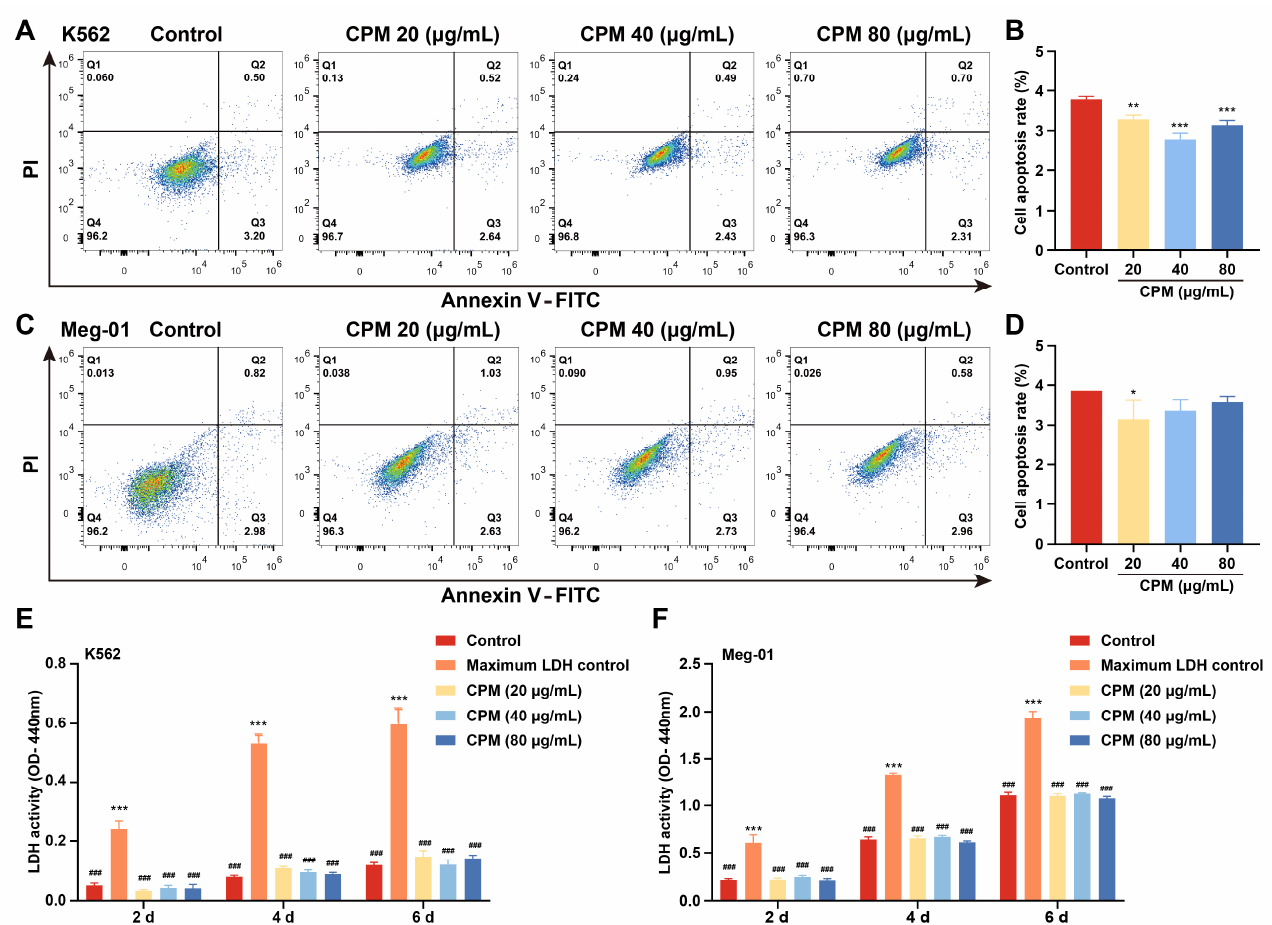
Figure 2. Cytotoxicity of CPM. ( A , C ) Apoptosis analysis in K562 and Meg-01 cells after treatment with or without CPM (20, 40 and 80 µg/mL) for 5 days. Q2 (Annexin + PI + ) denotes late apoptotic. Q3 (Annexin + PI − ) denotes early apoptotic cells. ( B , D ) Q2 + Q3 represents total apoptotic cells. Statistical analysis of apoptotic cells (Q2 + Q3) of K562 and Meg-01 cells in each group. Data are means ± SD (n = 3). ( E , F ) Detection of LDH activity of K562 and Meg-01 cells after treatment with or without CPM (20, 40 and 80 µg/mL) for 2, 4 and 6 days. Maximum LDH control represents the total amount of LDH present in the cells. Data are mean ± SD (n = 3, ANOVA). * p < 0.05, ** p < 0.01, *** p < 0.001 vs. the control group. ### p < 0.001 vs. the maximum LDH control.